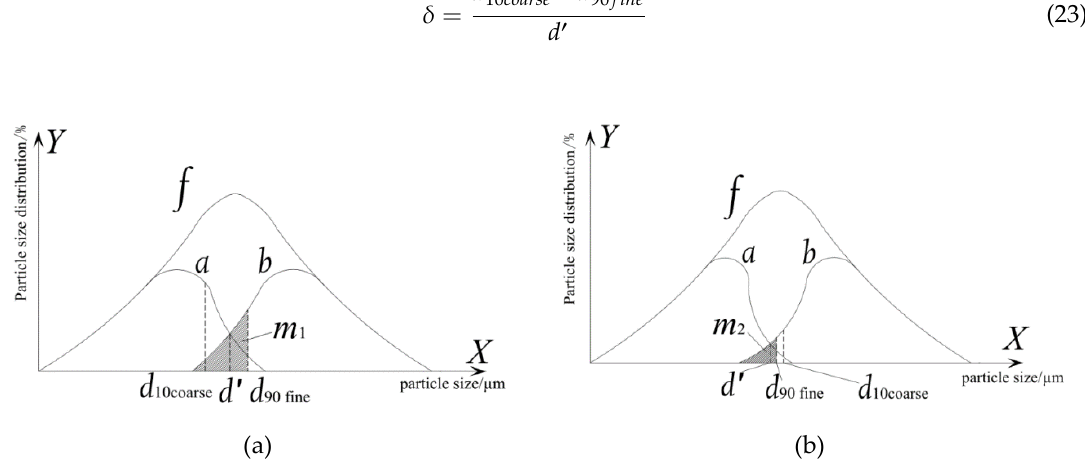
Figure 10. Coarse- and fine-grade product size distribution curve. ( a ) d 10 coarse < d 90fine. ( b ) d 10 coarse > d 90 fine